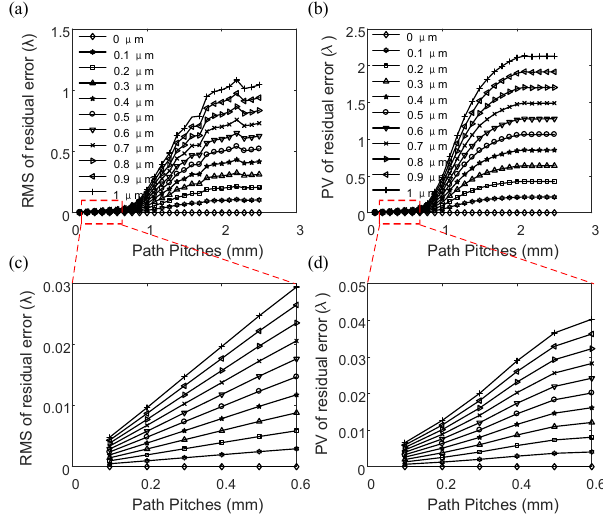
Figure 4. The influence of path spacing variations on the ( a , c ) root-mean-square (RMS) and ( b , d ) peak-to-valley (PV) of the residual error resulting from different bulk material removal